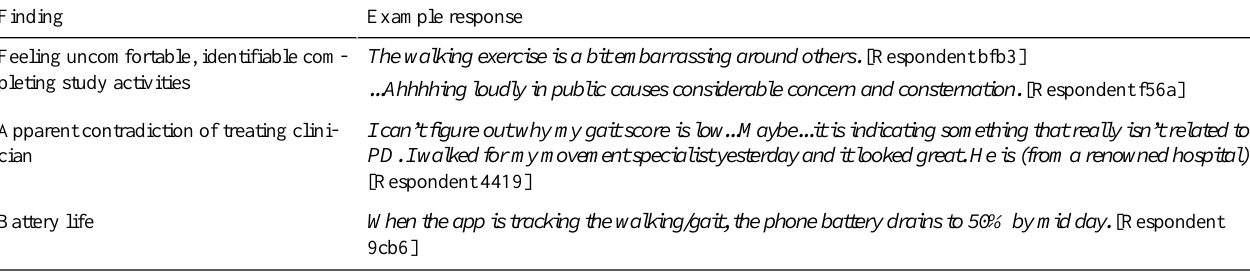
Table 3. Risks raised by responders not highlighted within the electronic informed consent (eConsent) process. Example